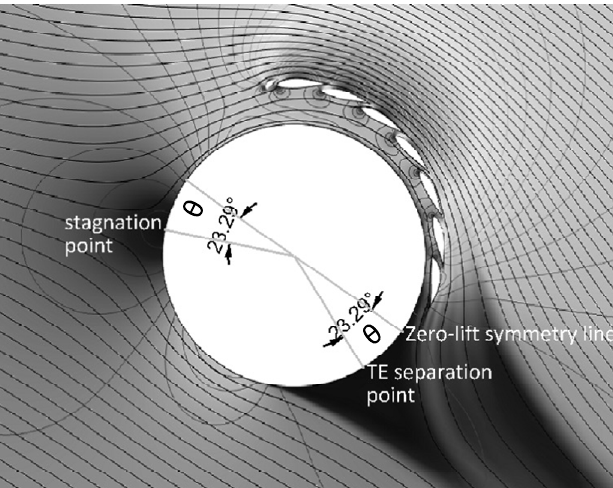
Figure 7. Visualization of RANS CFD computation of flow past circular cylinder with guide vanes. Black lines: Streamlines; Lighter colored lines: iso-pressure